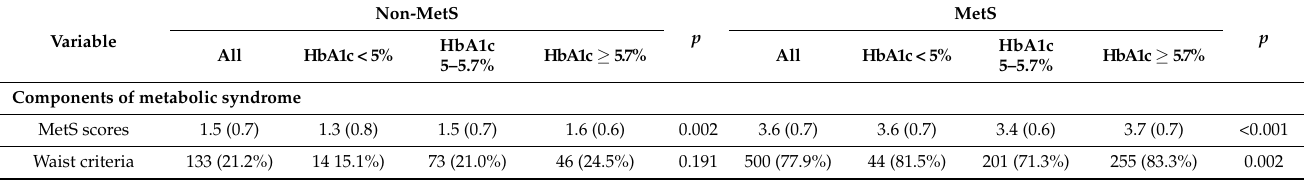
Table 2. Baseline characteristics of components of metabolic syndrome in CKD stage 1–4